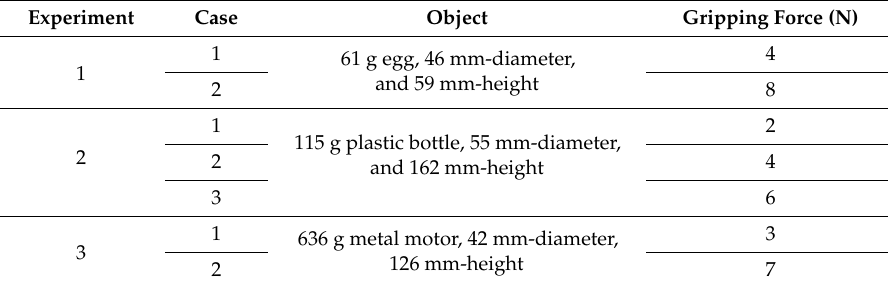
Table 5. The experiments for the comparison.